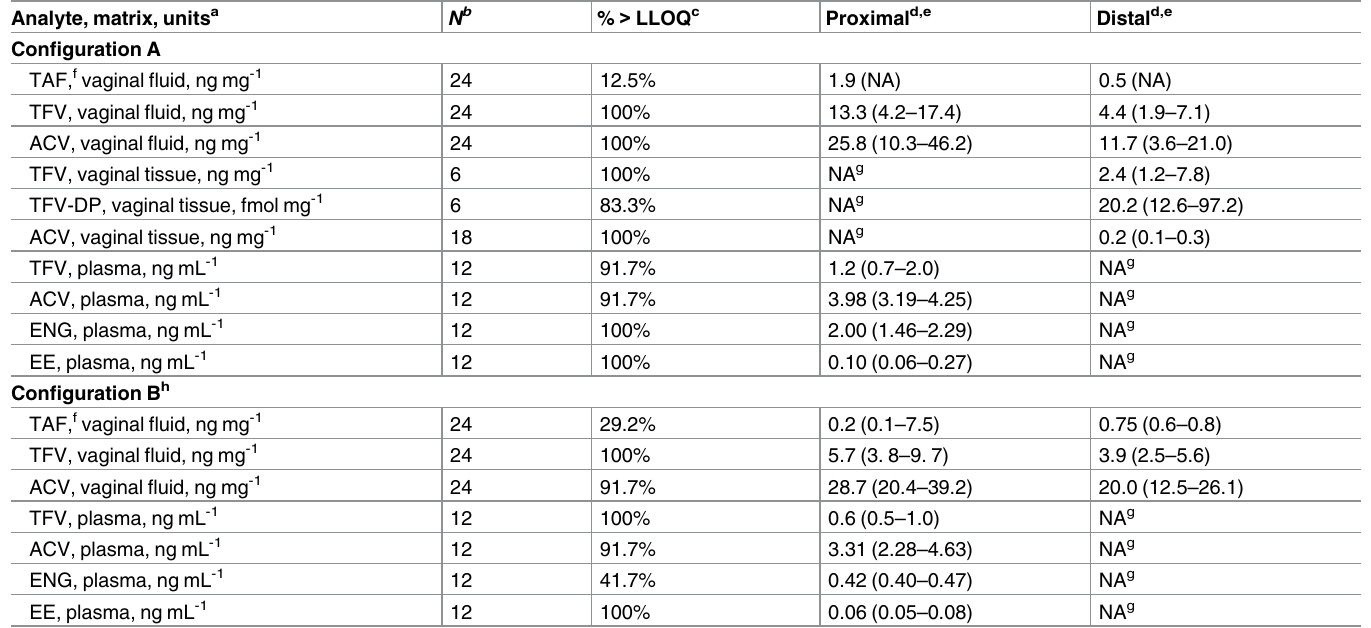
Table 4. Summaryof drug and drug metabolite concentrations at all sampled anatomic sites (six animals). Analyte, matrix, units